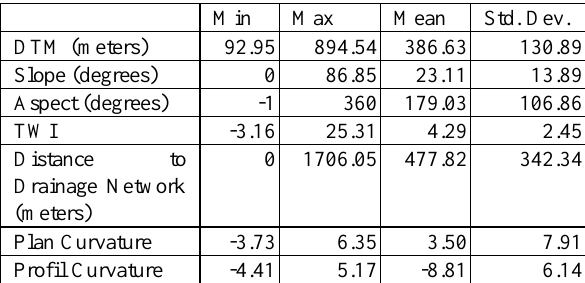
Table 1. Statistical summary of the topographical data obtained for the whole study dataset.